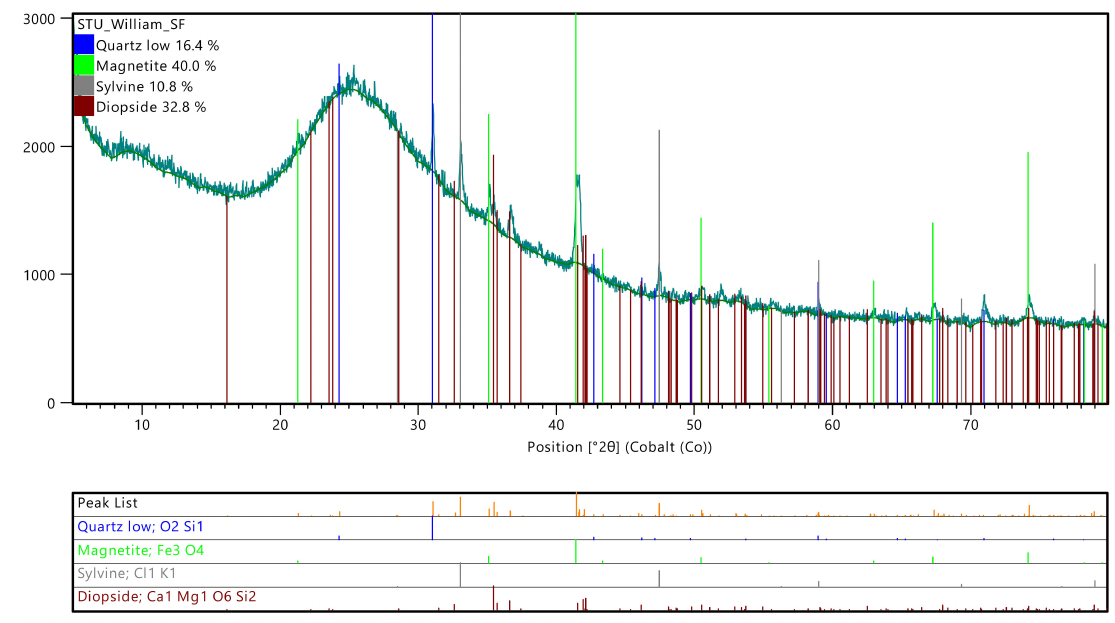
Figure 2. Diffractogram for